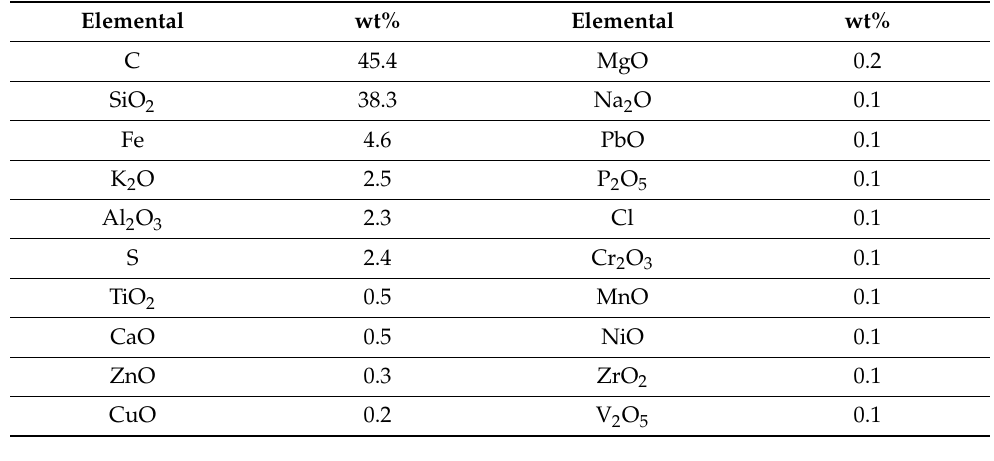
Table 1. Elemental composition (weight%) of shungite.